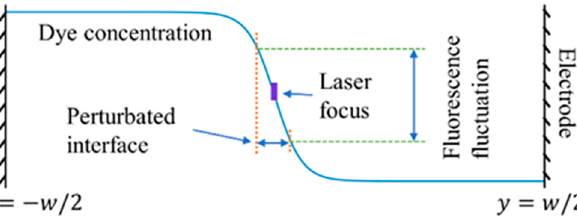
Figure 5. Schematic of a small perturbation of the flow leads to an amplified fluctuation of fluores- cence.